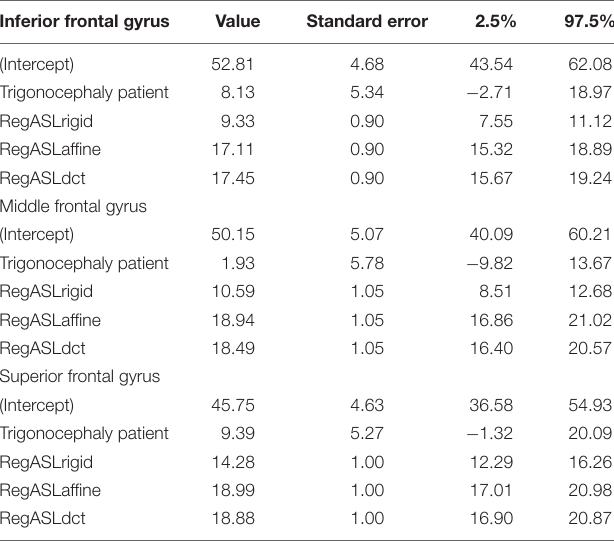
TABLE 4 | Linear mixed model for the three gyri of the frontal lobes of 41 subjects using the Hammers Atlas (ml/100